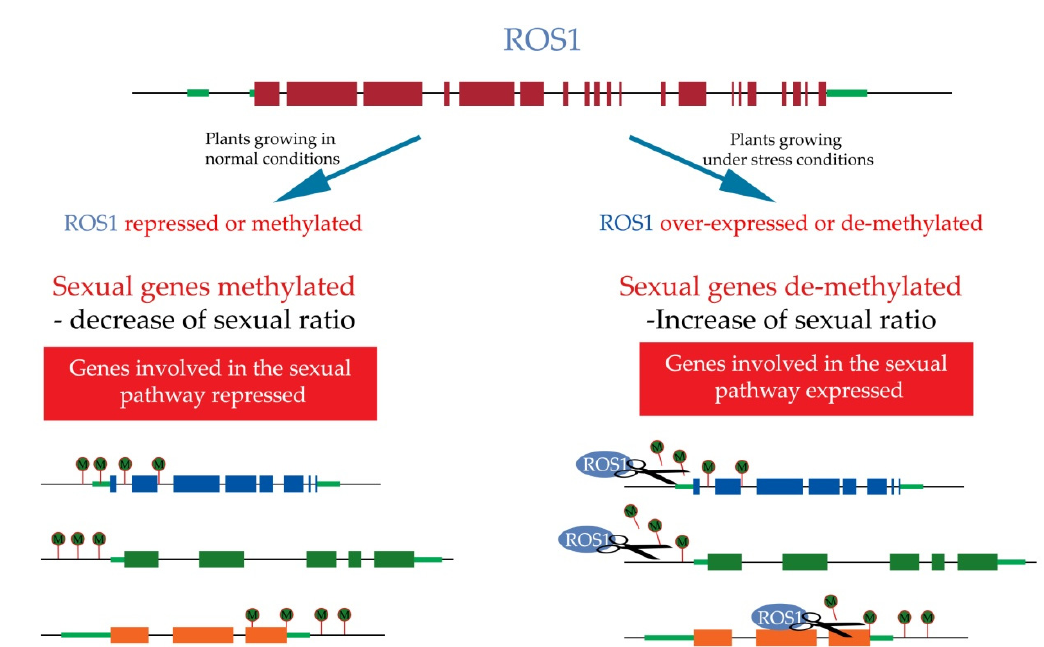
Figure 4. Hypothetical model of the quantitative regulation of diplosporous apomixis mediated by ROS1. Green circles attached to the genes represent methylated positions over putative genes involved in the sexual pathway. This situation is observed when plants grow under normal conditions and ROS1 is repressed or de-methylated. Blue ovals represent ROS1 de-methylating genes involved in the sexual pathway when plants are exposed to stressful conditions. As a consequence, the sexual ratio increases.